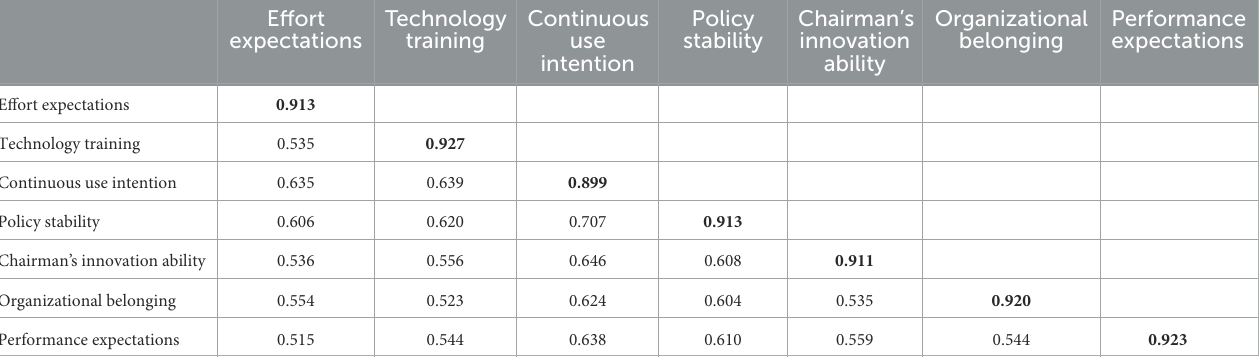
TABLE 3 Results of discriminant validity tests.